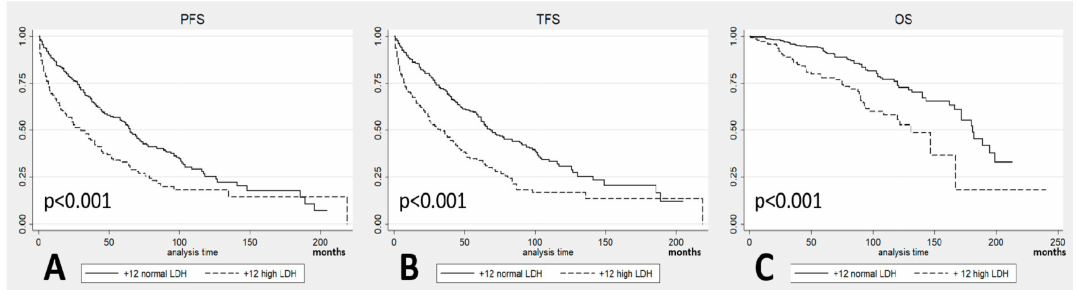
Figure 2. ( A ) Progression-free-survival (PFS) in patients with + 12 stratified according to Lactate DeHydrogenase (LDH) levels; ( B ) Treatment-free-survival (TFS) in patients with + 12 stratified according to LDH levels; ( C ) Overall survival (OS) in patients with + 12 stratified according to LDH levels.